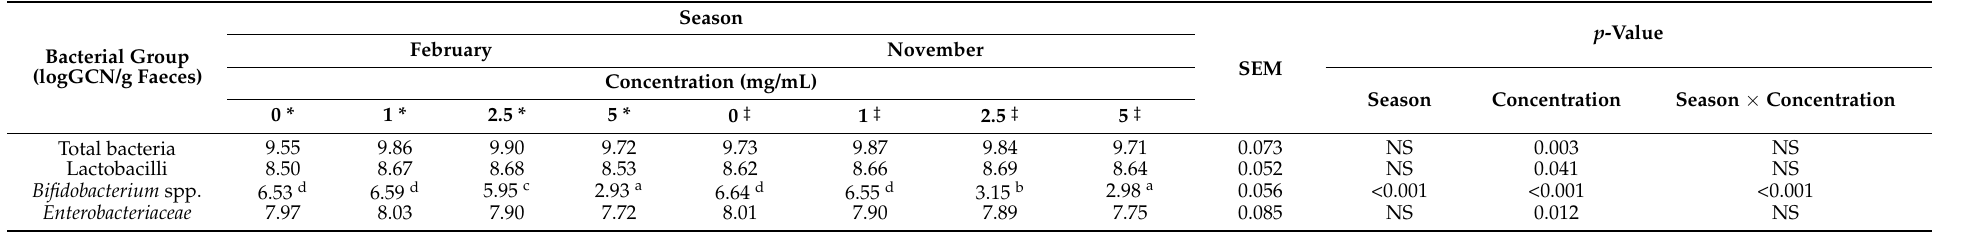
Table 6. Effect of harvest season and seaweed concentration on the selected bacterial populations of the faecal microbiota in the batch fermentation assay (least-square means and standard error of the